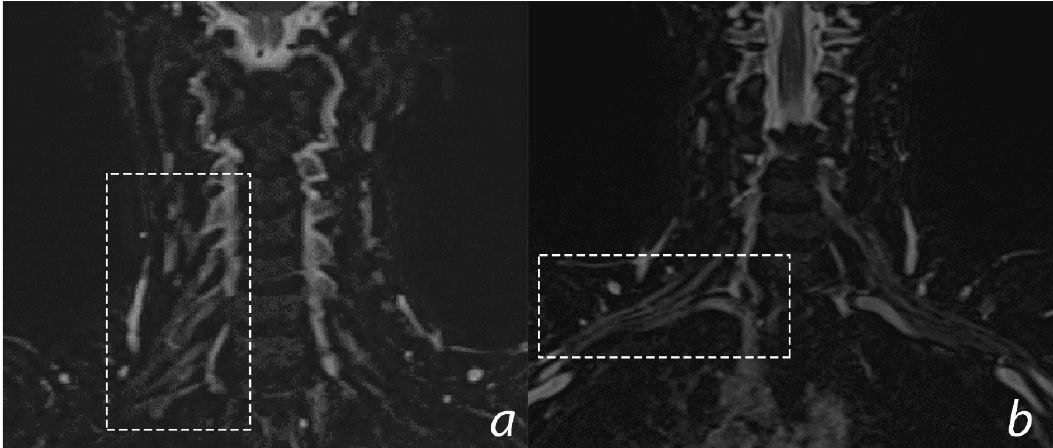
Figure 3. 3D T2 STIR SPACE sequence—coronal images of normal Brachial Plexus. ( a ) Dotted rectangle includes cervical spinal nerves emerging from the intervertebral foramina in the supraclavicular laterocervical region; ( b ) dotted rectangle includes the brachial plexus structures passing through the cervicoaxillary canal.